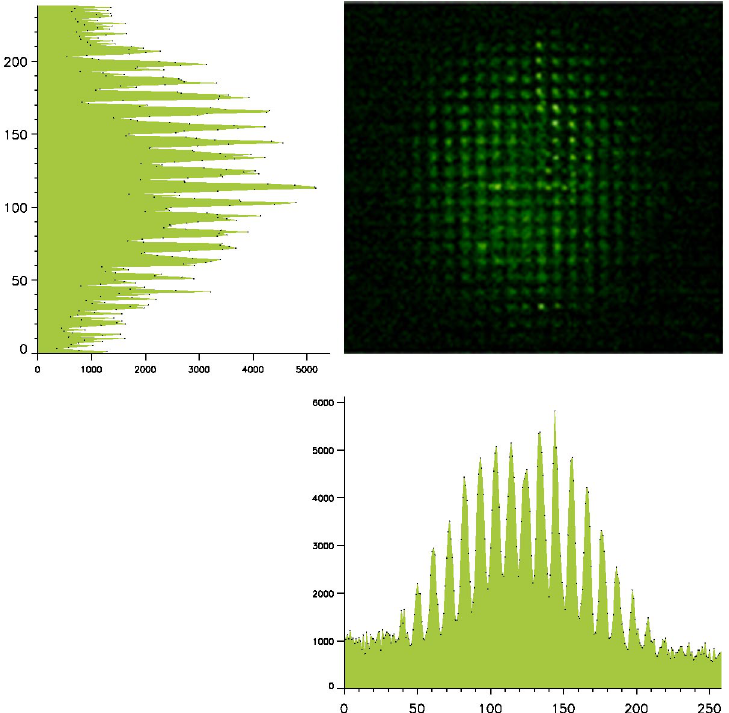
FIG. 5. (Color) Pinhole array measurement. The beamlets were imaged on a P43 phosphor screen. The histograms show intensity in arbitrary units vs pixel